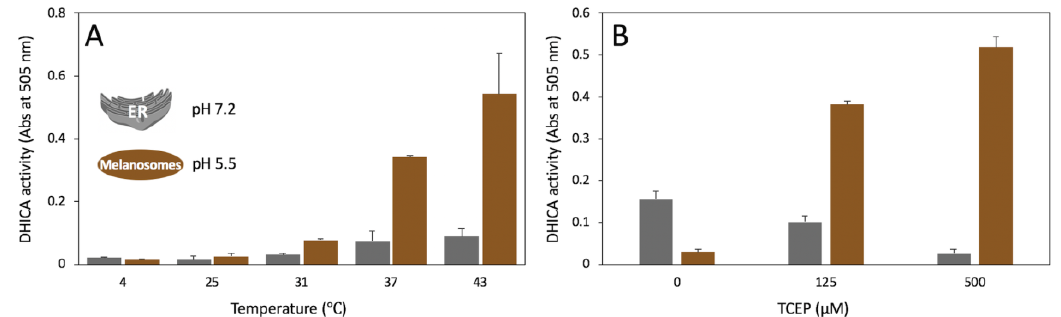
Figure 7. Tyrp1tr diphenol oxidase activity measured to mimic pH conditions in the ER (pH 7.2) and melanosomes (pH 5.5). Panel A: Tyrp1tr diphenol oxidase activities measured at pH 7.2 (grey bars) and 5.5 (brown bars) using DHICA as a substrate. The reaction mixture containing 3 mM DHICA and 3 mM MBTH in GF buffer including 50 µM TCEP, pH 7.2 or 5.5, was incubated for 180 min at 4, 25, 31, 37, and 43 °C and monitored by measuring the IQCA/MBTH formation at 505 nm. Panel B: Tyrp1tr diphenol oxidase activities measured at pH 7.2 (grey bars) and 5.5 (brown bars) using DHICA as a substrate in the presence of different concentrations of TCEP. The reaction mixtures containing 3 mM DHICA, 3 mM MBTH, and 0, 125, or 500 µM TCEP in GF buffer, pH 7.2 and 5.5 were incubated for 180 min at 37 °C and monitored by measuring the IQCA/MBTH complex formation at 505 nm.